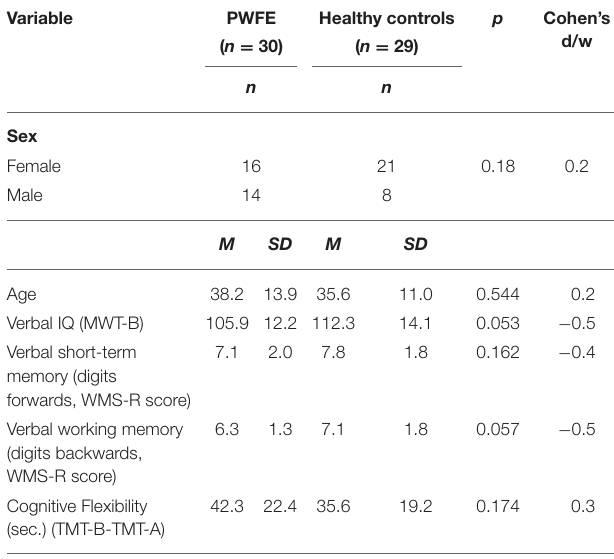
versus control subjects. Variable Healthy